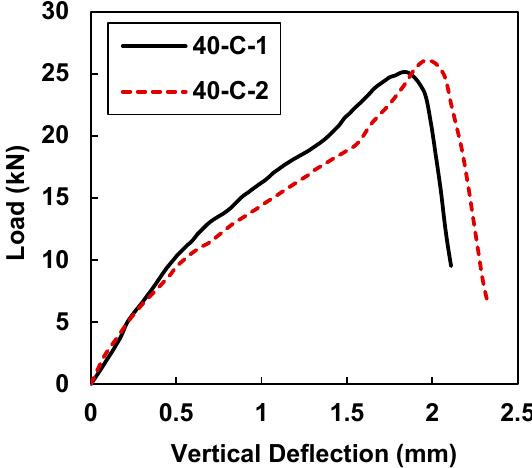
In comparison to the control samples, on average increase of 152.54% in value was observed in the load-carrying capacity as well as a 92.31% increase in the deflection. Table 5 shows the maximum load and midspan deflection values of 23.66 kN and 1.734 mm for sample 30-C-1, whereas sample 30-C-2 showed maximum load and midspan deflection values of 22.04 kN and 1.776 mm. In comparison to the beam samples that were retrofitted with 20 mm CFRP strips, an average increase of 16.46% in the load-carrying capacity and a 10.76% increase in the deflection were observed. By increasing the width of the CFRP from 20 mm to 30 mm, a slight improvement in the displacement carrying capacity was observed. Figure 9 and Table 5 show the peak load and midspan deflection values of 25.16 KN and 1.841 mm for sample 40-C-1, whereas sample 40-C-2 had maximum load and midspan deflection values of 26.06 kN and 1.985 mm.